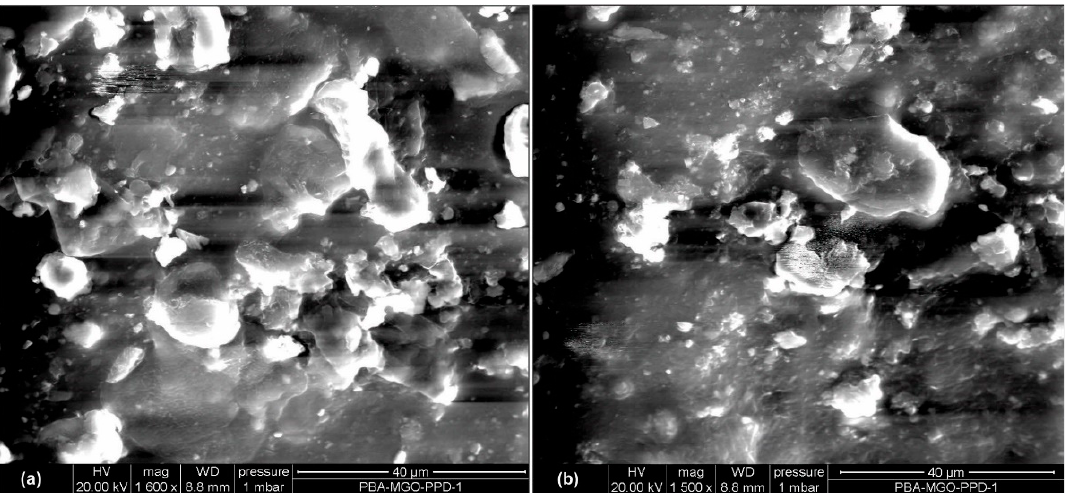
Figure 12. Scanning electron microscopy (SEM) of ( a ) 1% MPGE with a crosslinking agent and ( b ) 1% MPGE.